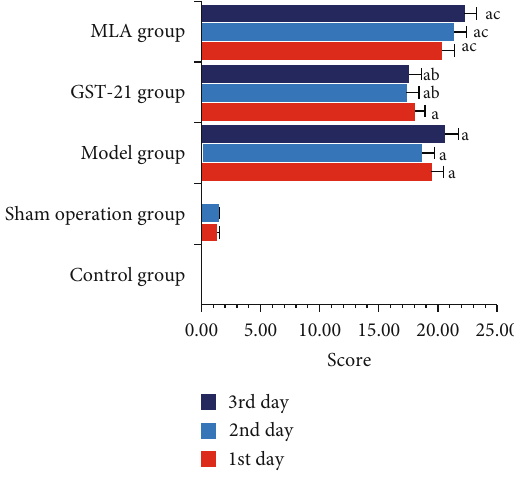
Figure 2: MSS of rats in di ff erent groups. The average MSS scores of the model group, GTS-21 group, and MLA group were much higher than those of rats in the control group and those of rats in the control group. P value and 95% CI (con fi dence interval) were, respectively, 0.000, -21.215 ∼ -17.745; 0.00, -19.064 ∼ -16.222; and 0.00, -23.359 ∼ -18.841. The average MSS score of the MLA group was much higher than that of rats in the GTS-21 group; the P value and 95% CI were, respectively, 0.003 and 0.906 ∼ 6.009. The average MSS scores of the GTS-21 group were much lower than those of the model group; the P value and 95% CI were, respectively, 0.039 and -3.621 ∼ -0.054. a: P < 0 : 05 vs. control group; b: P < 0 : 05 vs. model group; c: P < 0 : 05 vs. GTS-21